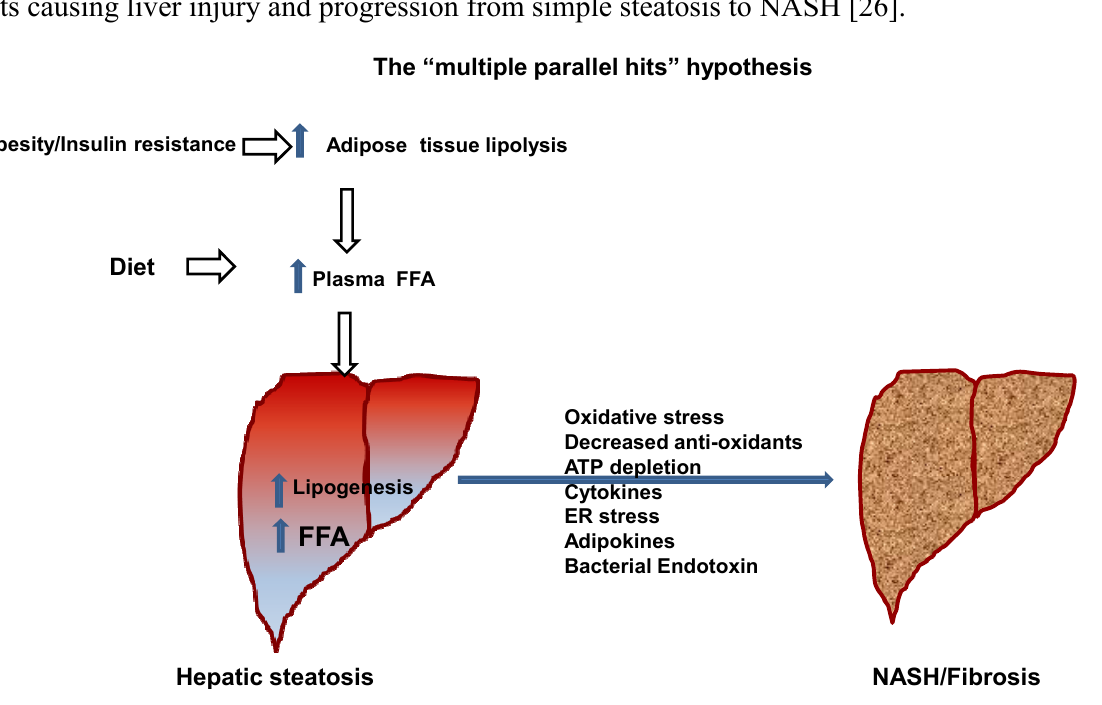
Figure 1. The “multiple parallel-hits” hypothesis of NAFLD: Insulin resistance leads to increased uptake and synthesis of FFAs in the liver, which sensitizes the liver to a series of hits causing liver injury and progression from simple steatosis to NASH